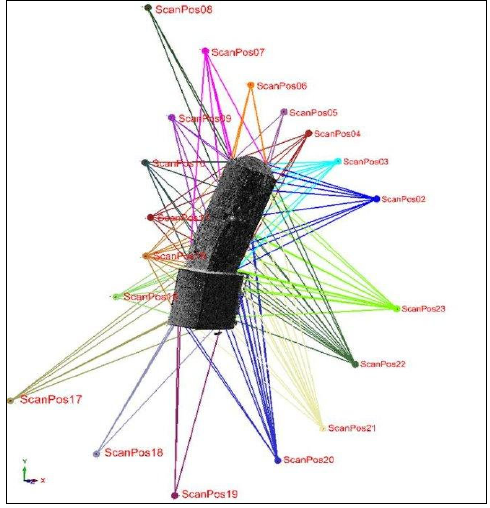
Figure 3. Overview of the aligned scans with all TSL